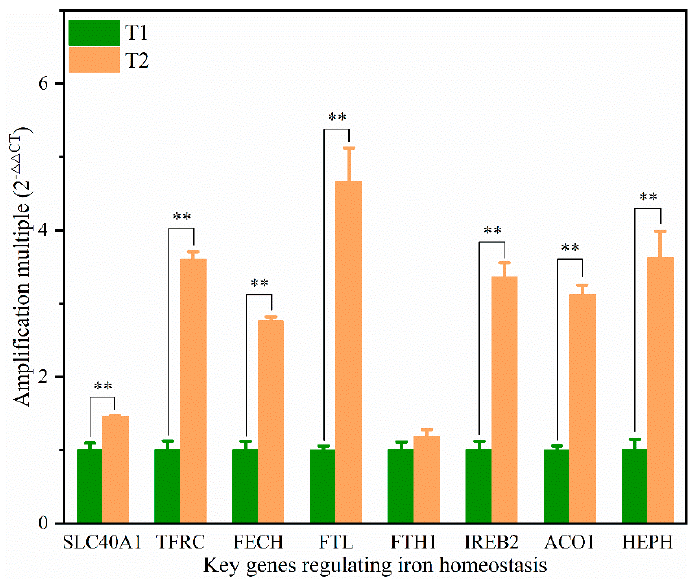
Figure 6. Expression levels of the key genes regulating iron homeostasis in the liver of broilers from T1 and T2. Actin was used as the internal reference. SLC40A1: Solute carrier family 40 protein, TFRC: Transferrin receptor, FECH: Ferrochelatase, FTL: Ferritin, Light polypeptide, FTH1: Ferritin, Heavy chain 1, ACO1: Aconitate hydratase 1, IREB2: Iron responsive element binding protein 2, HEPH: Hephaestin. ** is significant at p < 0.01.